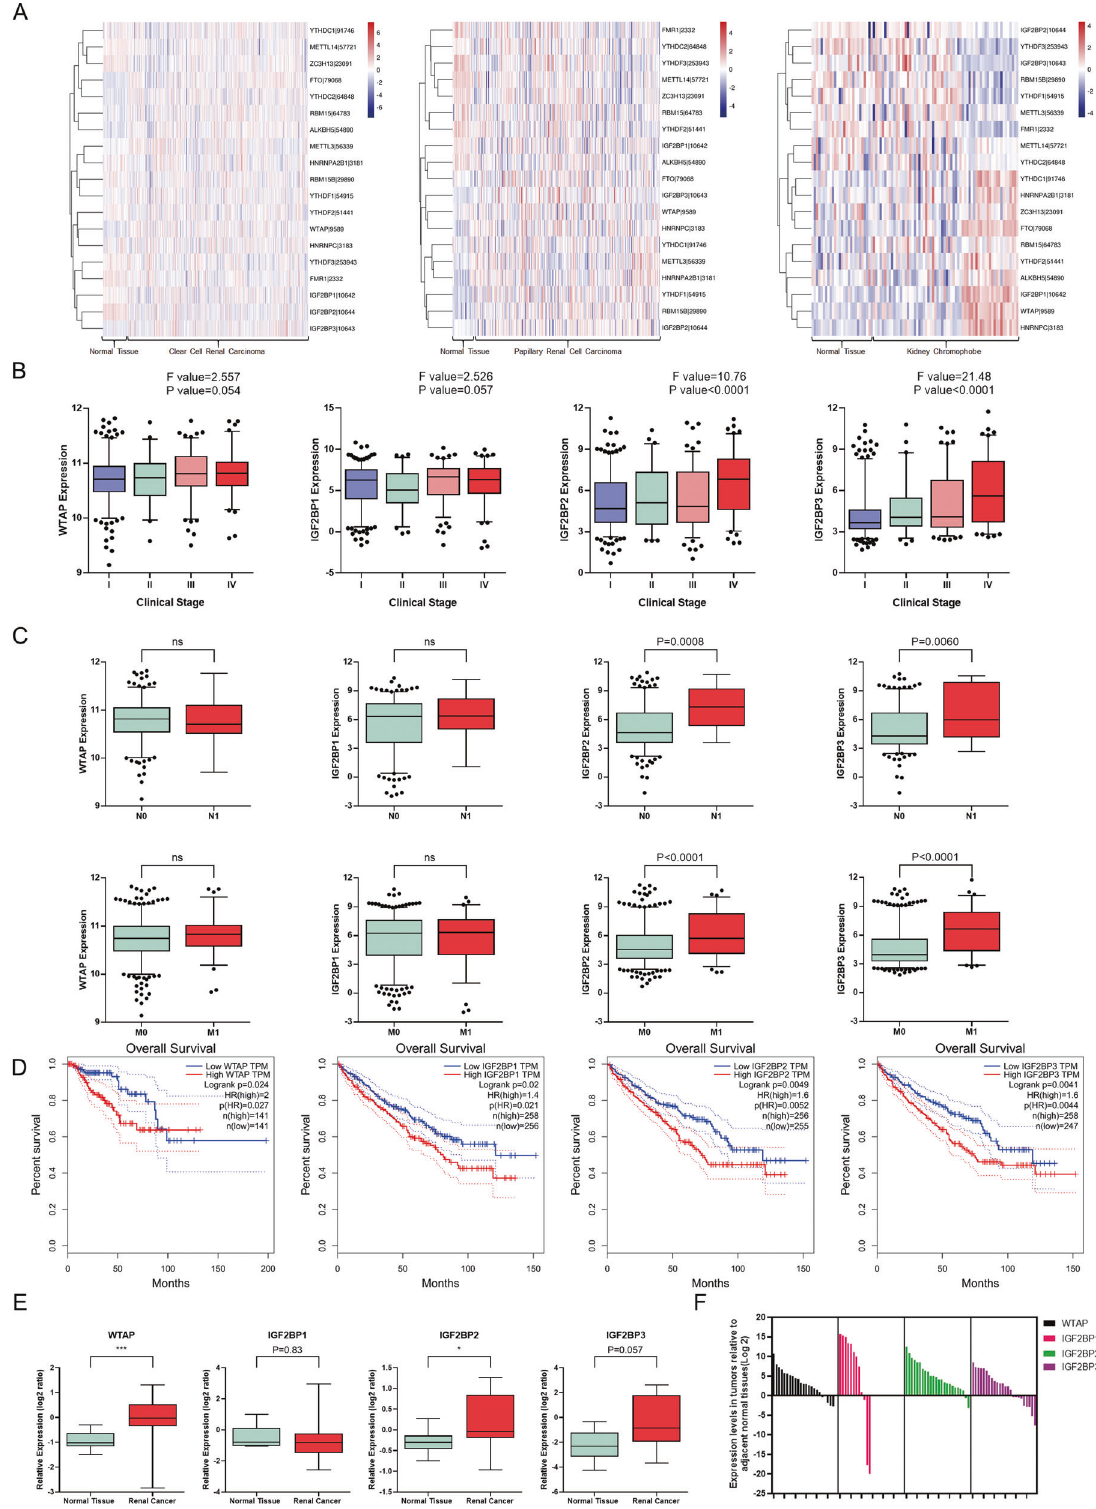
Fig. 1 Deregulation of m 6 A methylation enzymes leads to poor prognosis of RCC patients. A TCGA data showed the deregulated m 6 A regulators in different RCC patients. B , C Clinical features of RCC patients associated with WTAP, IGF2BPs genes expression. D Elevated expression of WTAP and IGF2BPs correlate with poor prognosis in RCC patients. E The mRNA levels of WTAP and IGF2BPs in RCC tissues and normal tissues according to the Oncomine database. F The mRNA levels of WTAP and IGF2BPs in RCC tissues relative to adjacent nonmalignant tissues are shown. Values in B , C , and E are mean ± SEM. * P < 0.05; ** P < 0.01; *** P <